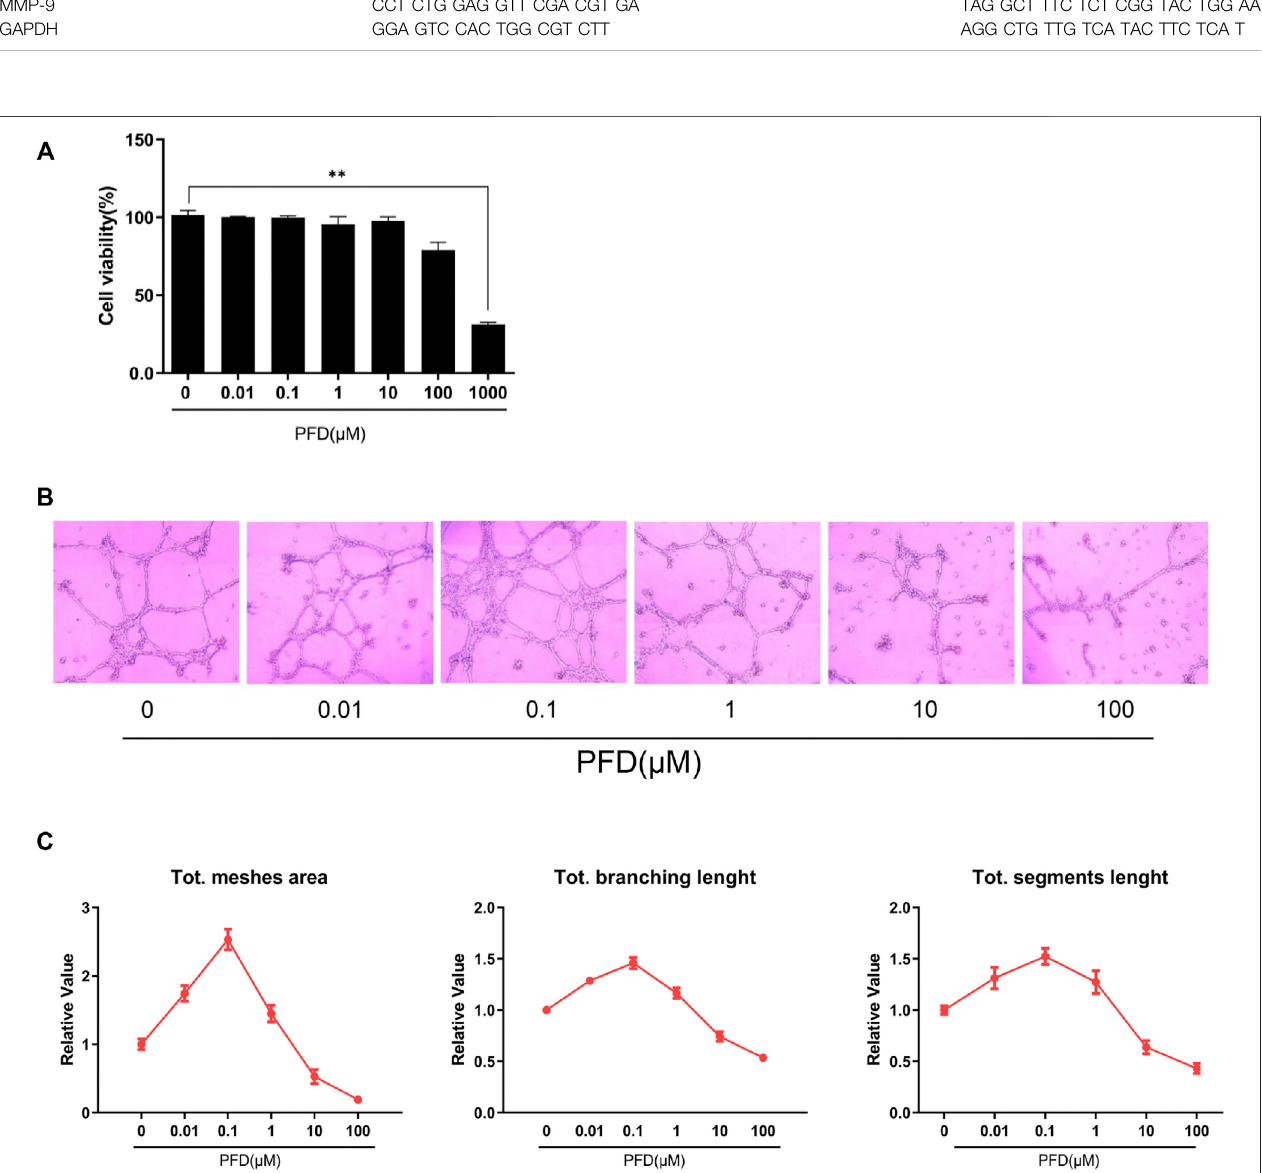
FIGURE 1 | Bidirectional effects of PFD on EA.hy926 cell tube formation: (A) Cell viability was measured by CCK-8 assay; (B) The effects of different PFD concentrations on EA.hy926 cell matrigel tube formation; (C) Semi-quantitative analysis result of matrigel tube formation. *Compared to control cells, * p < 0.05; ** p <